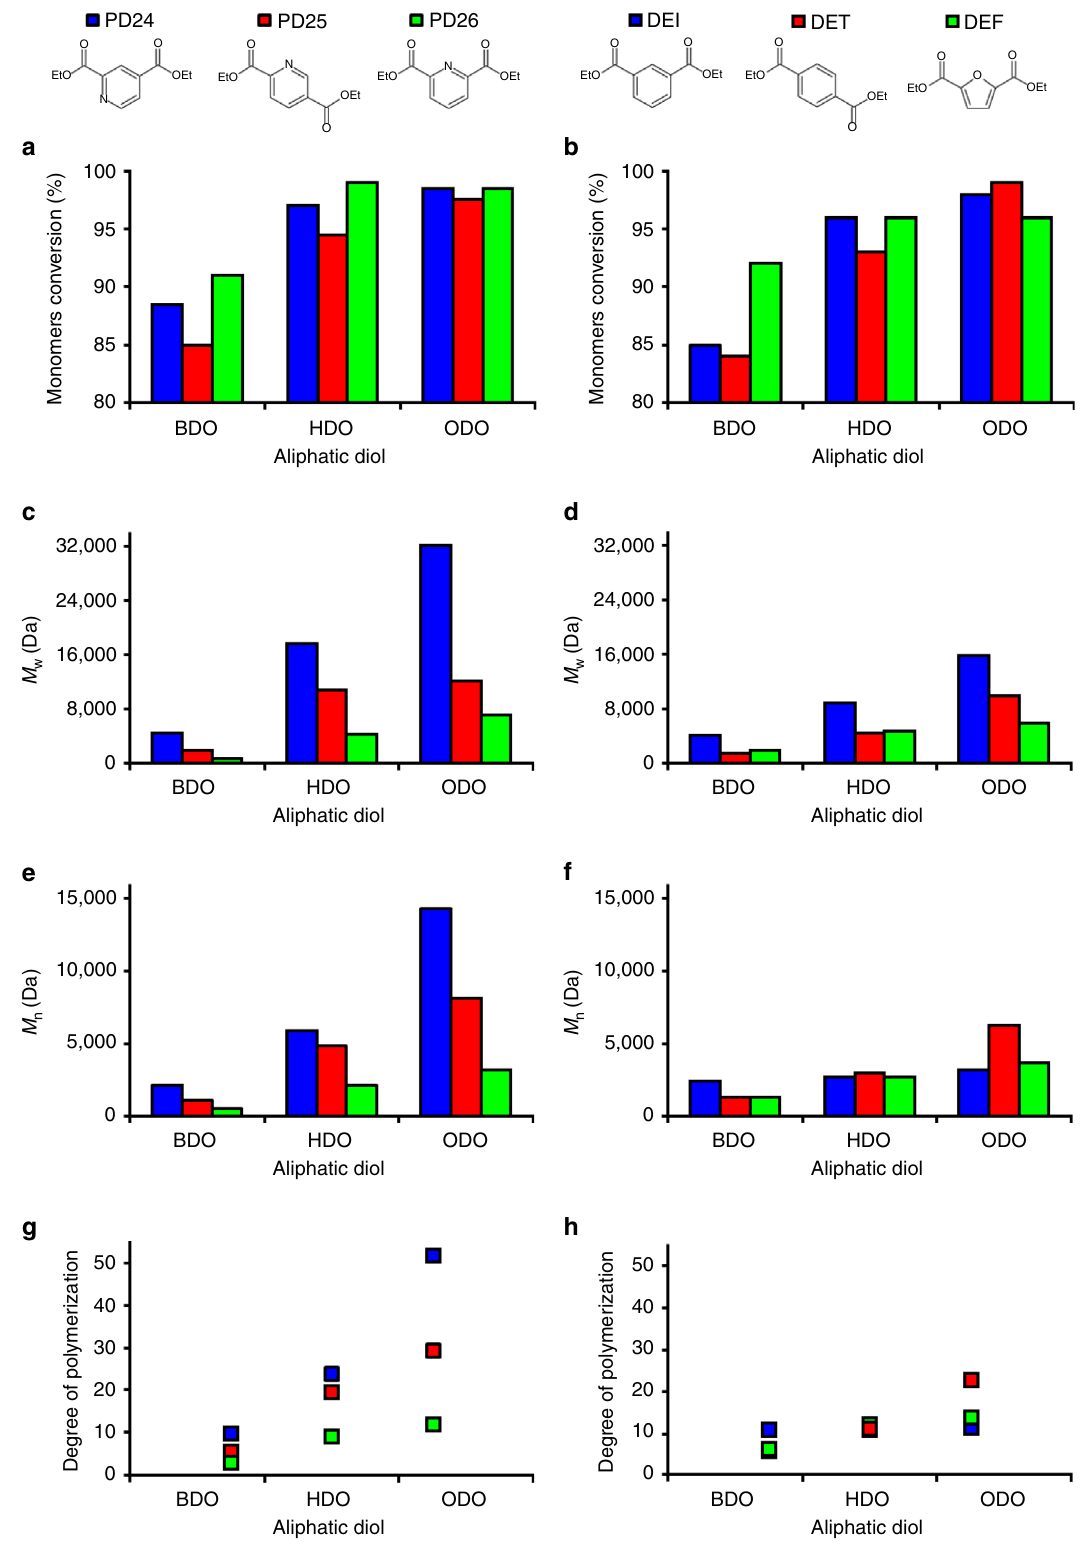
Fig. 3 Enzymatic synthesis of pyridine-based polyesters in DPE as organic media. a , b Monomers conversion calculated via 1 H-NMR spectroscopy; c , d number average molecular weight ( M n ) calculated via GPC; e , f weight average molecular weight ( M w ) calculated via GPC. g , h Degree of polymerization calculated dividing M n by the molecular mass of the polymer ’ s repetitive unit ( M 0